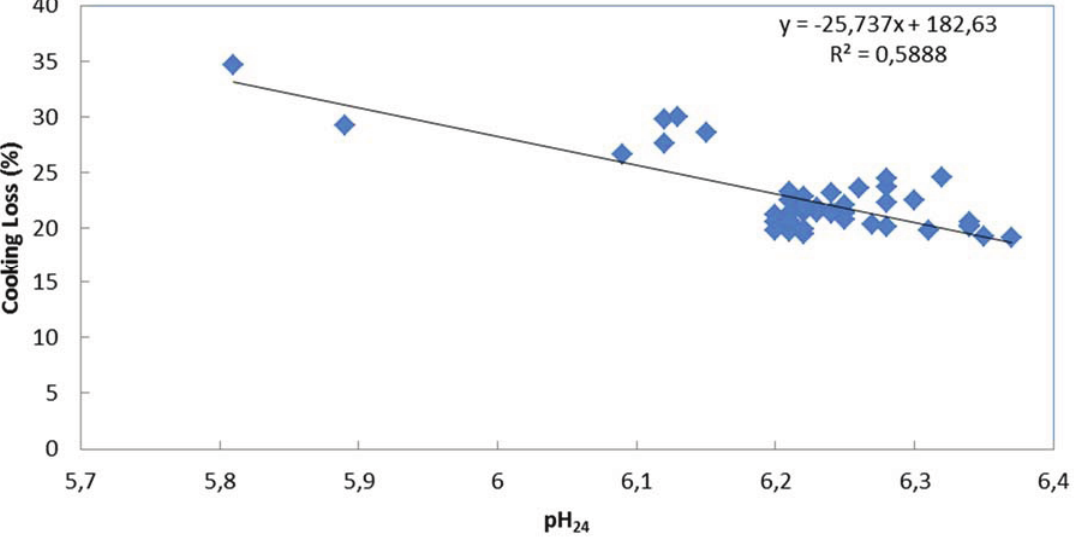
Figure 5. Linear correlation of percent cooking loss and ultimate pH (pH 24 ) of poorly-handled